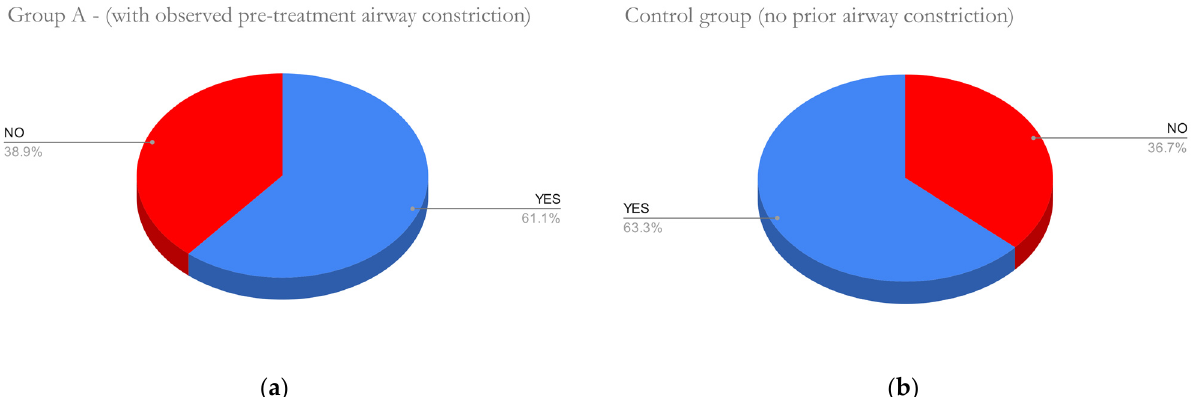
Figure 10. No significant difference between groups was observed. Difference of tongue contour towards palate and incisors between pre-treatment and post-treatment CBCT was assessed. ( a ) In Group A with significant pre-treatment airway constriction, a change of tongue position was ob- served in 61.1% of cases ( b ) Similarly, 63.3% cases of the control group had a change in tongue position after treatment.